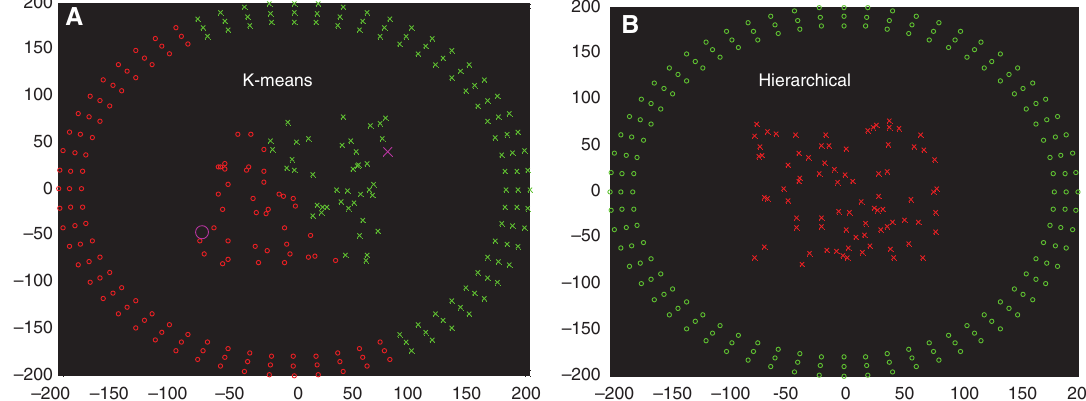
Figure 2: Clustering for ring arrangement by (A) K-means clustering technique and (B) hierarchical approach.